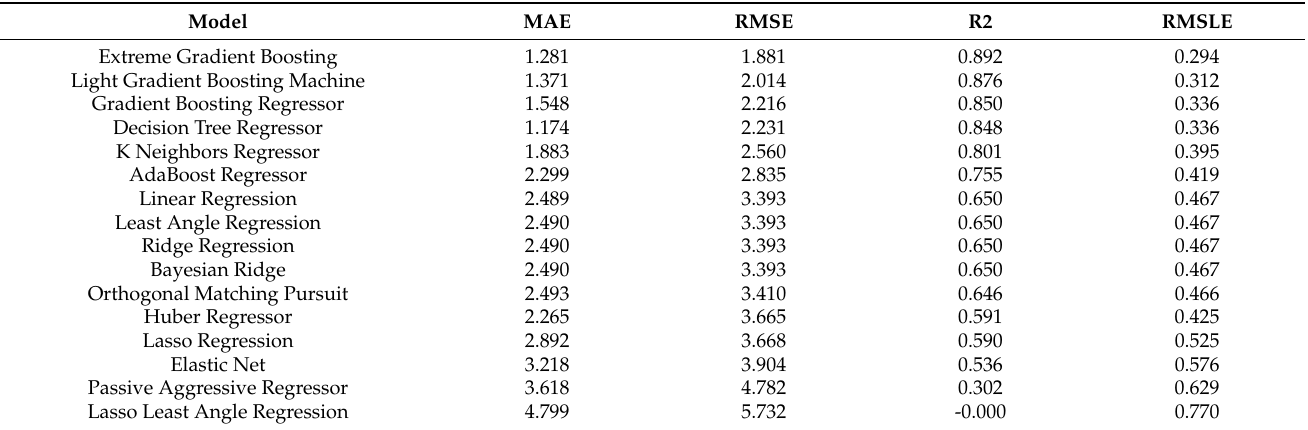
Table A4 shows the results for the different ML regression algorithms obtained for the Hybrid model. Table A4. Regression metrics for the Hybrid